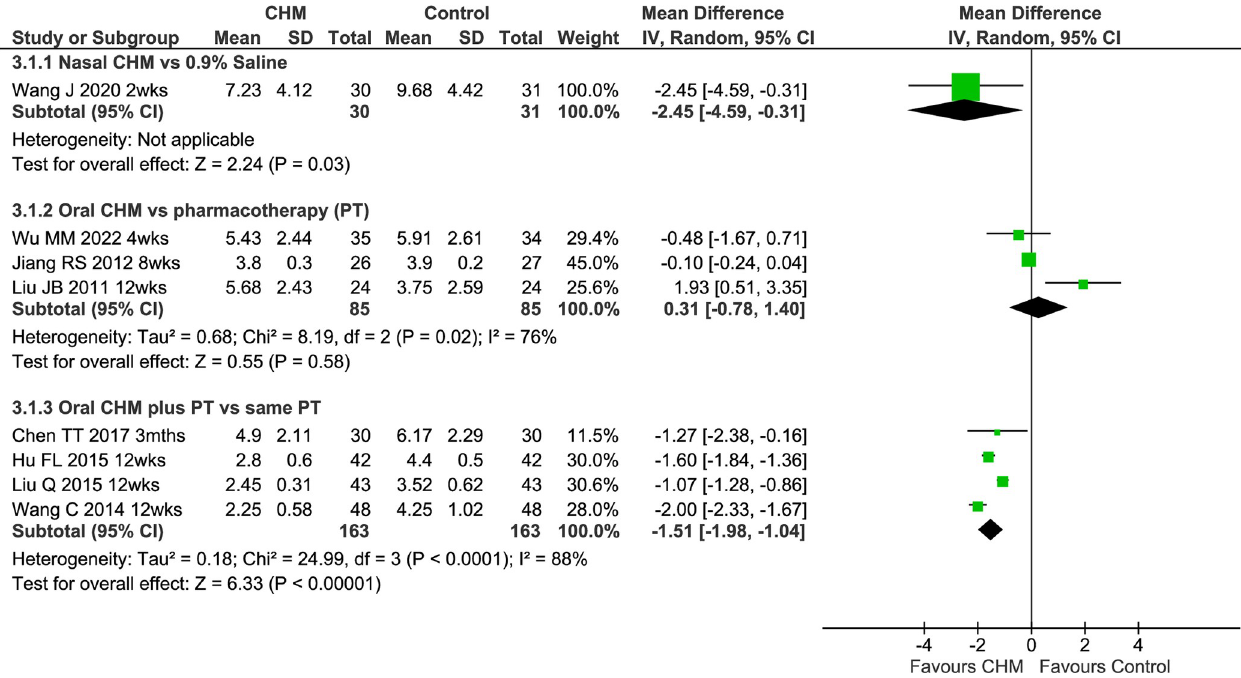
Fig 4. Forest plot of CHM for CRS at end of treatment for LM. Abbreviations: CHM: Chinese herbal medicine; CRS: chronic rhinosinusitis; DB: double blind; FU: follow-up; LM: Lund-Mackay computed tomography score; PT: pharmacotherapy; vs: versus; wks: weeks.